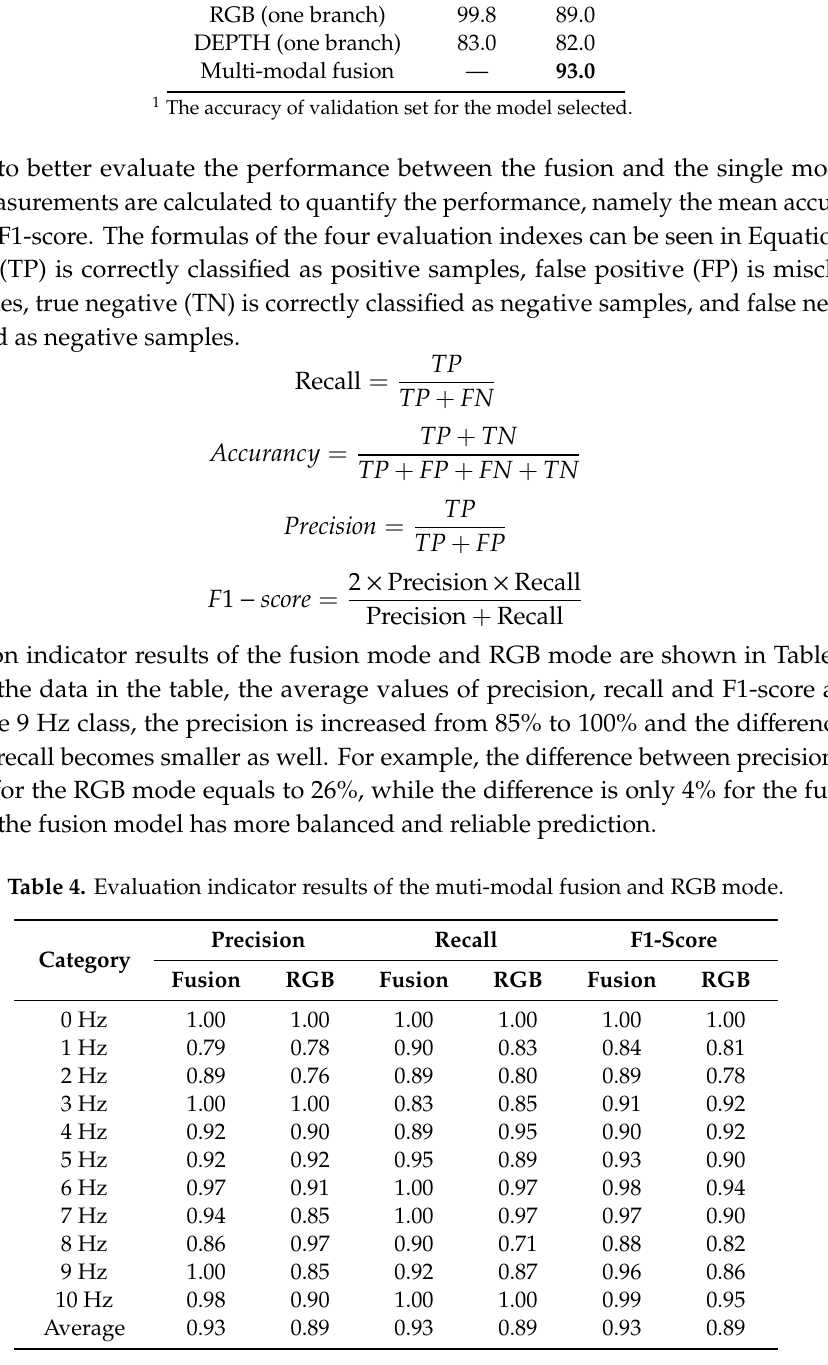
Accuracies (%) Models Val 1